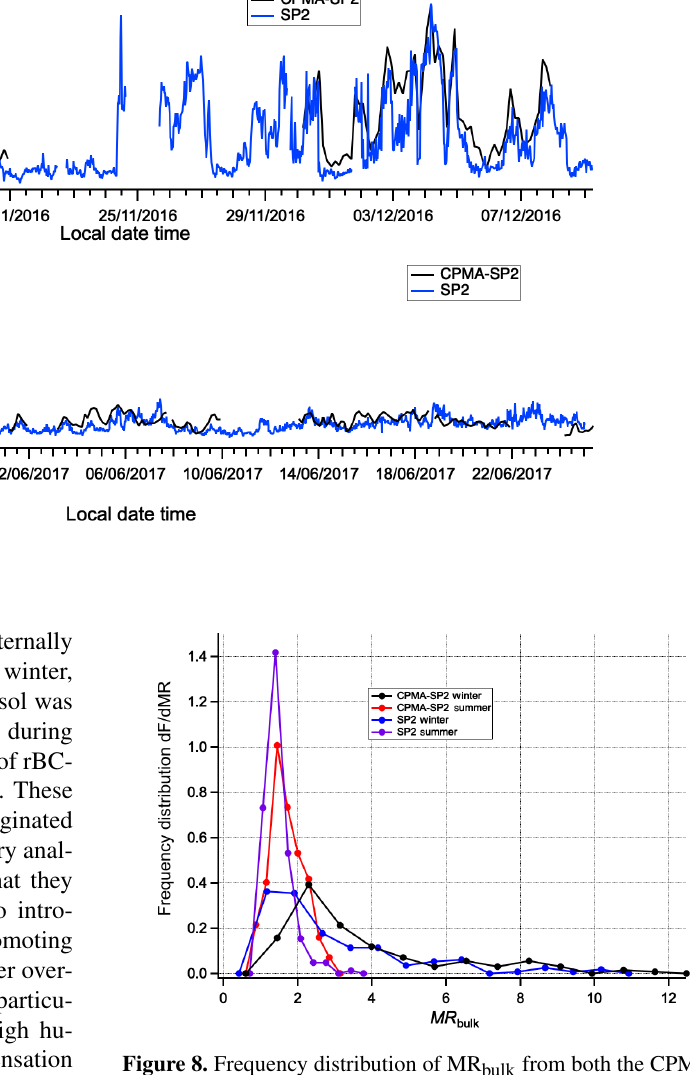
Figure 8. Frequency distribution of MR bulk from both the CPMA– SP2 and SP2-only